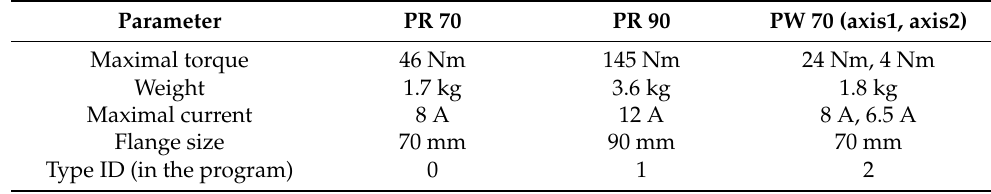
Figure 2. Schunk joint modules: ( a ) PR 70; ( b ) PR 90; ( c ) PW 70. The simulated counterparts: ( d ) PR 70; ( e ) PR 90; ( f ) PW 70. Table 1. Joint module physical parameters.